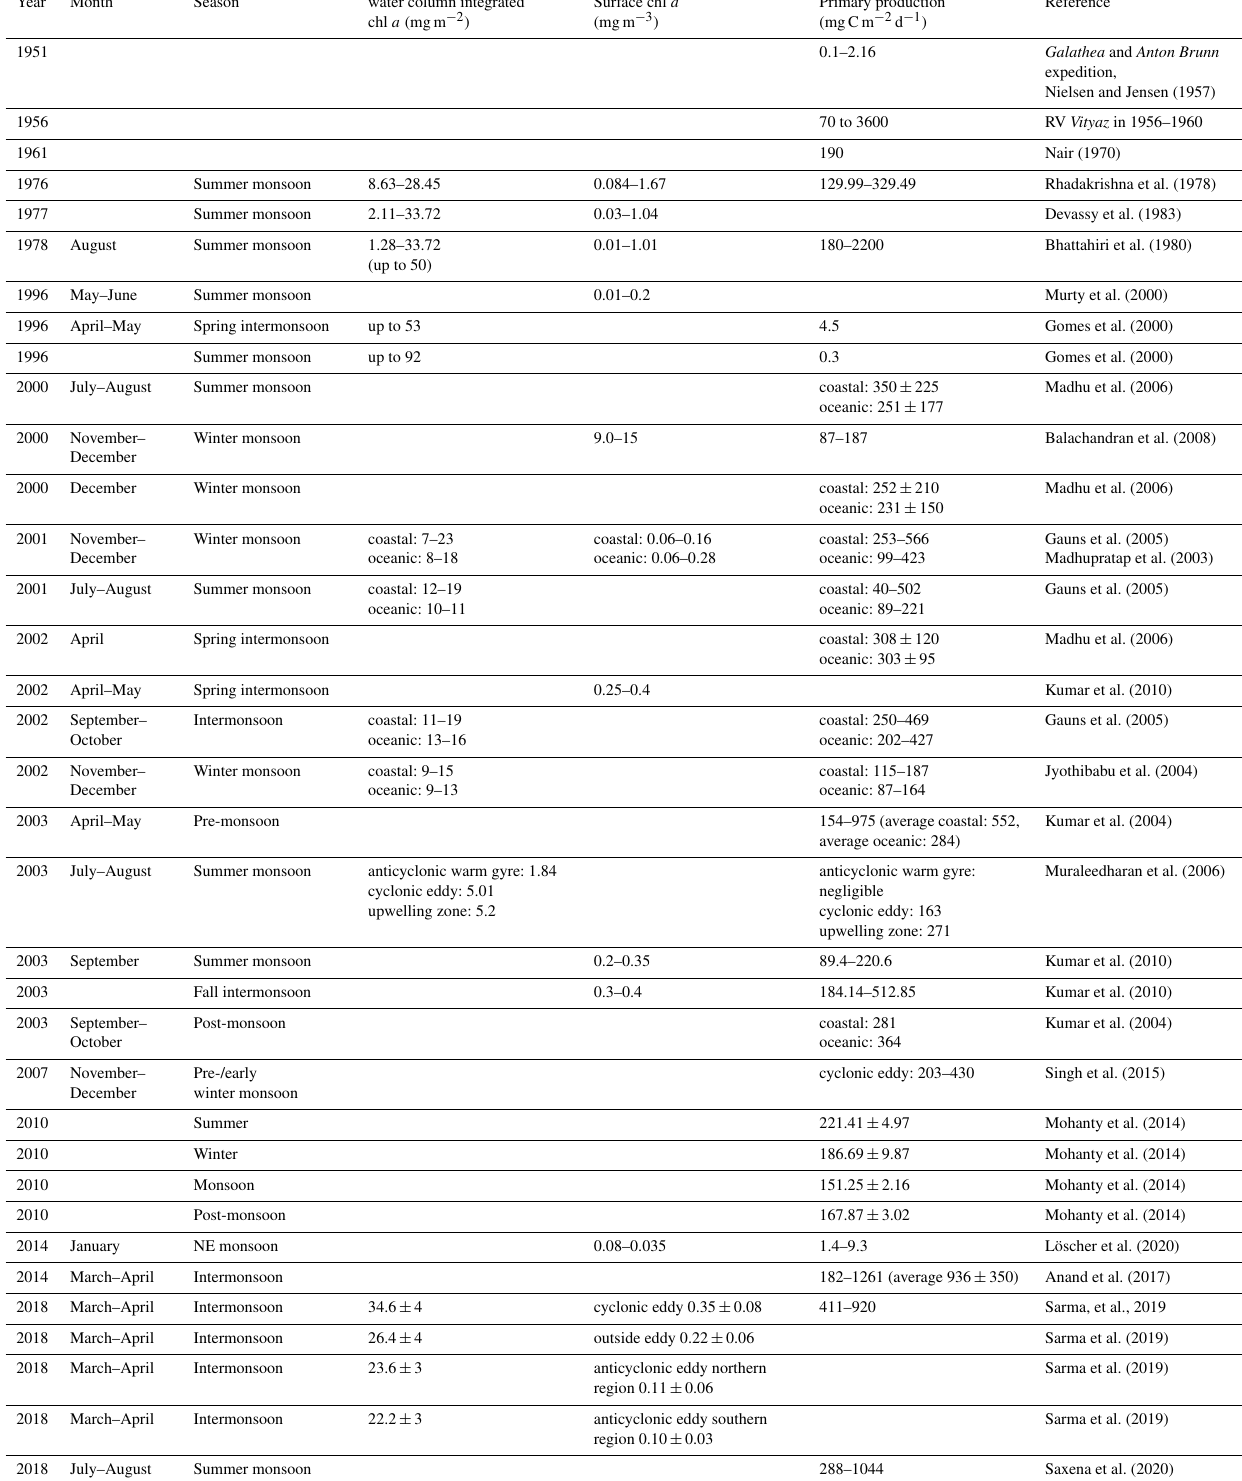
Table 1. Historical record of water-column-integrated chlorophyll a concentration, surface chlorophyll a concentration, and primary produc-